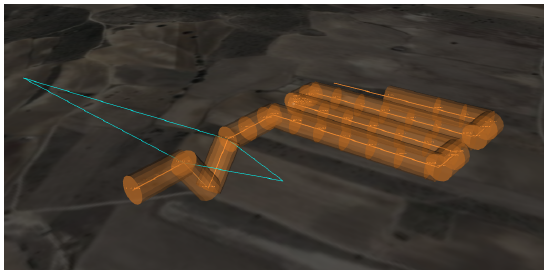
Figure 16. A perspective view of the conflict resolution in the use case 1. A new flight plan for UAS 1 (with a final go down maneuver) was selected to keep the safety distance with UAS 2 . The other alternative maneuvers generated by the TD module ( go left and go right ) are also shown.